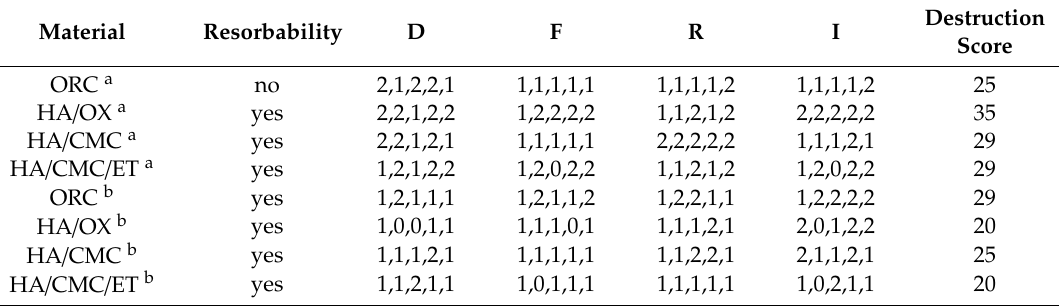
Table 1. Evaluated histopathological